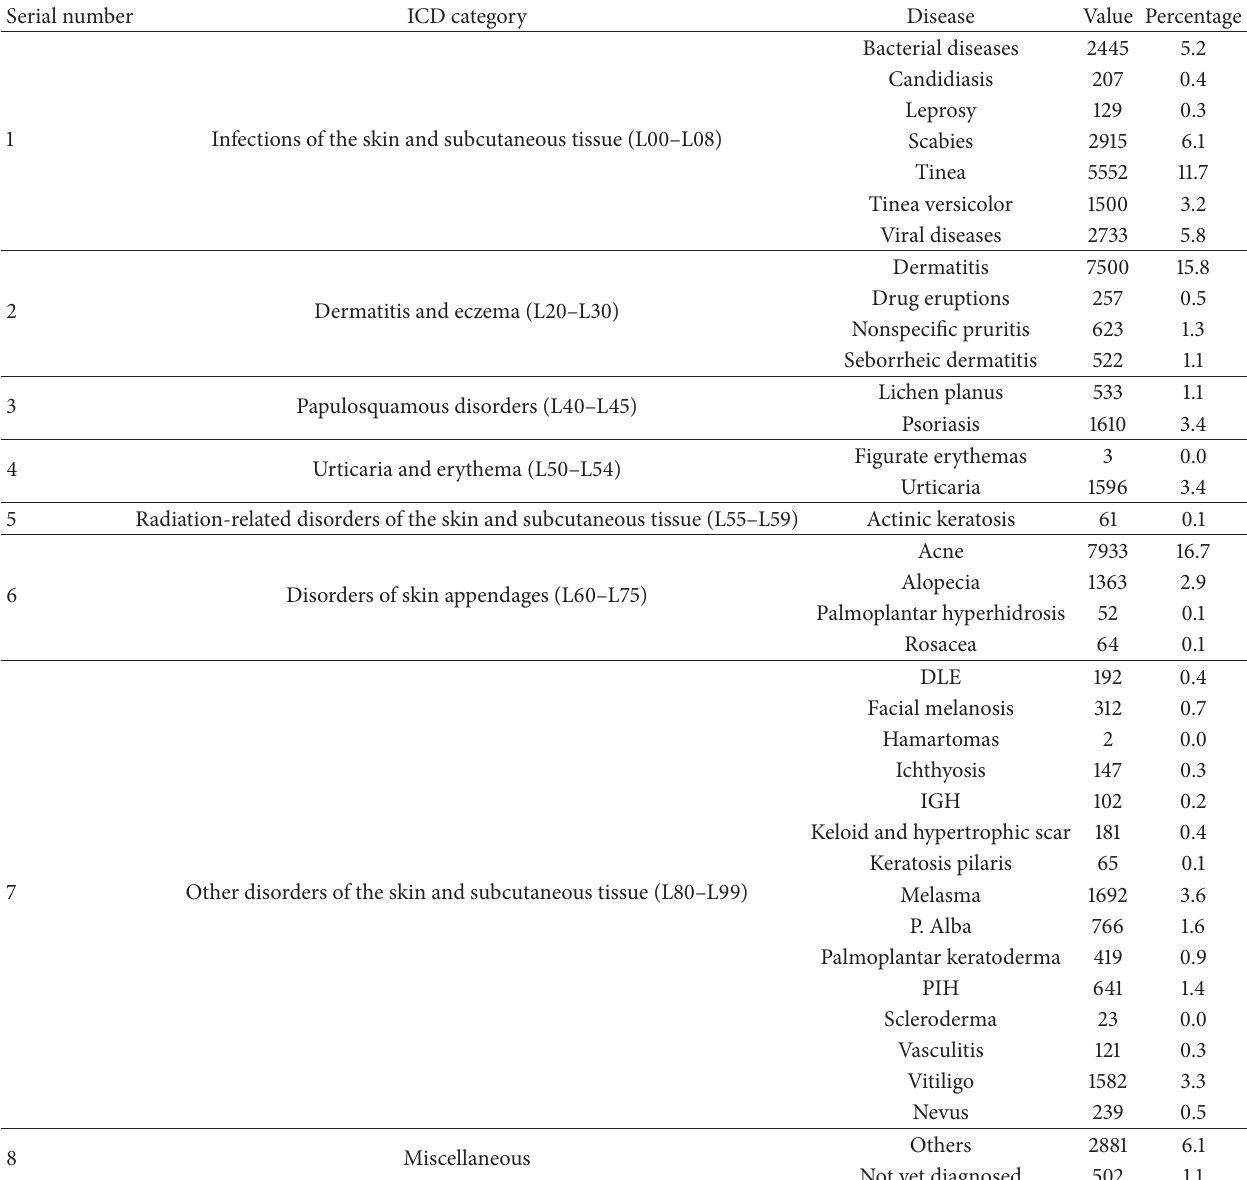
Table 1: Pattern of skin diseases among patients at dermatology OPD, tertiary care hospital, Srinagar,